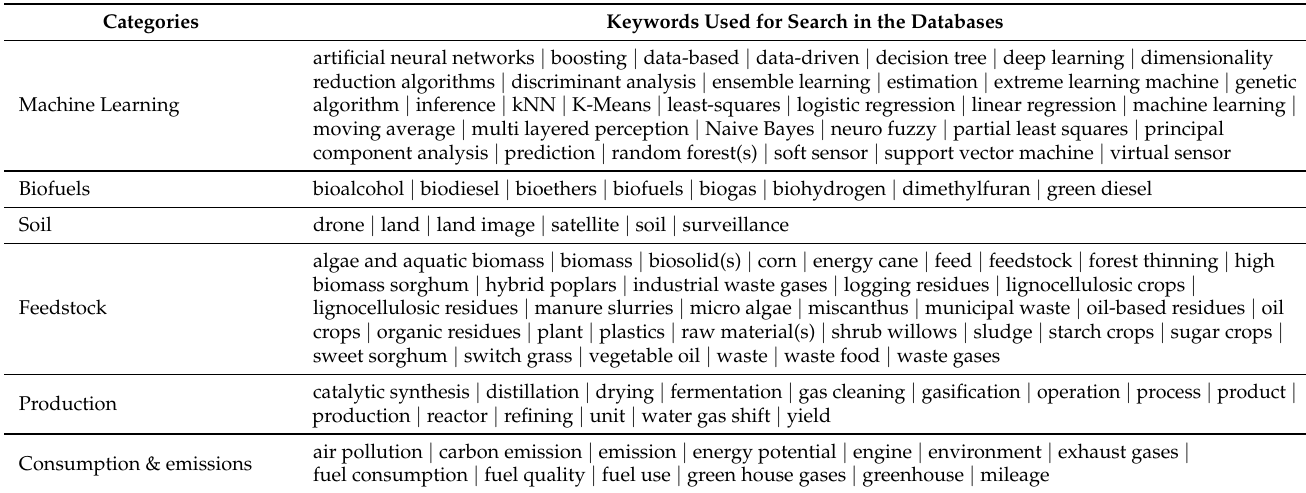
Table 1. Keywords used in literature